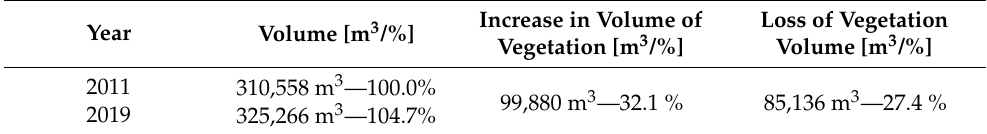
Table 2. Changes in vegetation volume (area 3D).